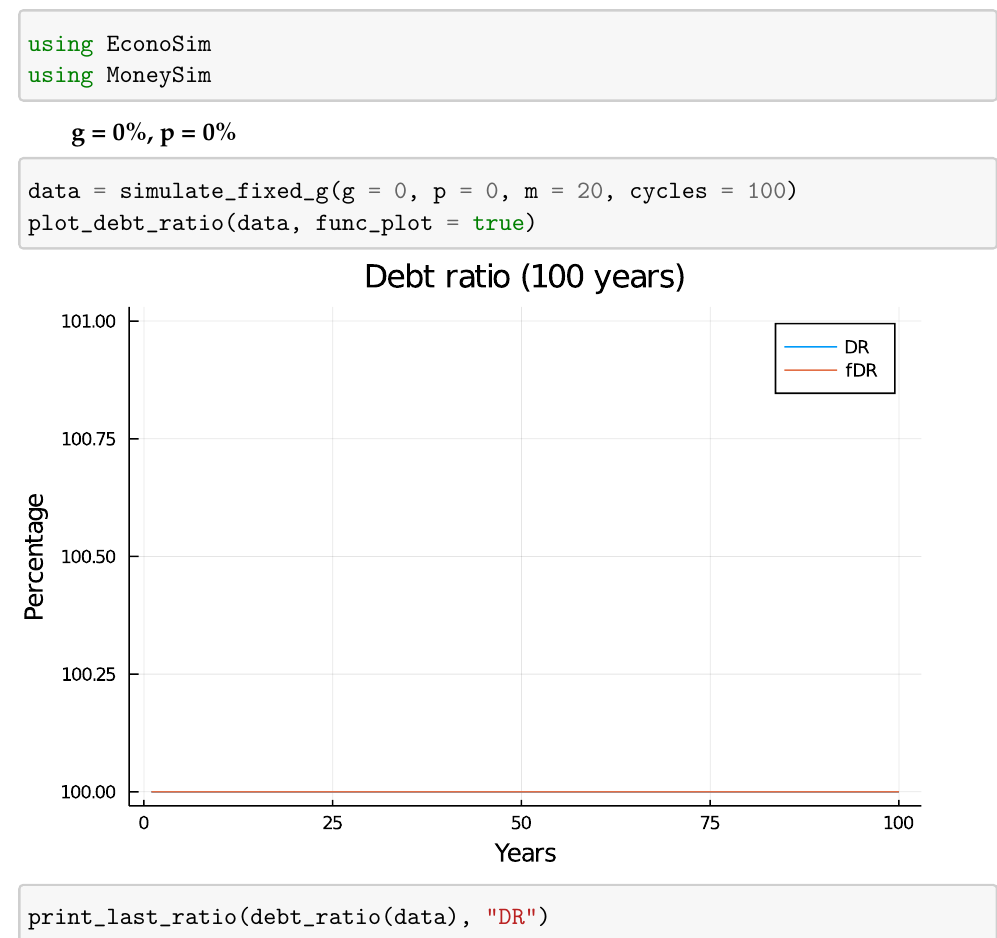
Figure 3. Debt ratio (g = 0%, p =